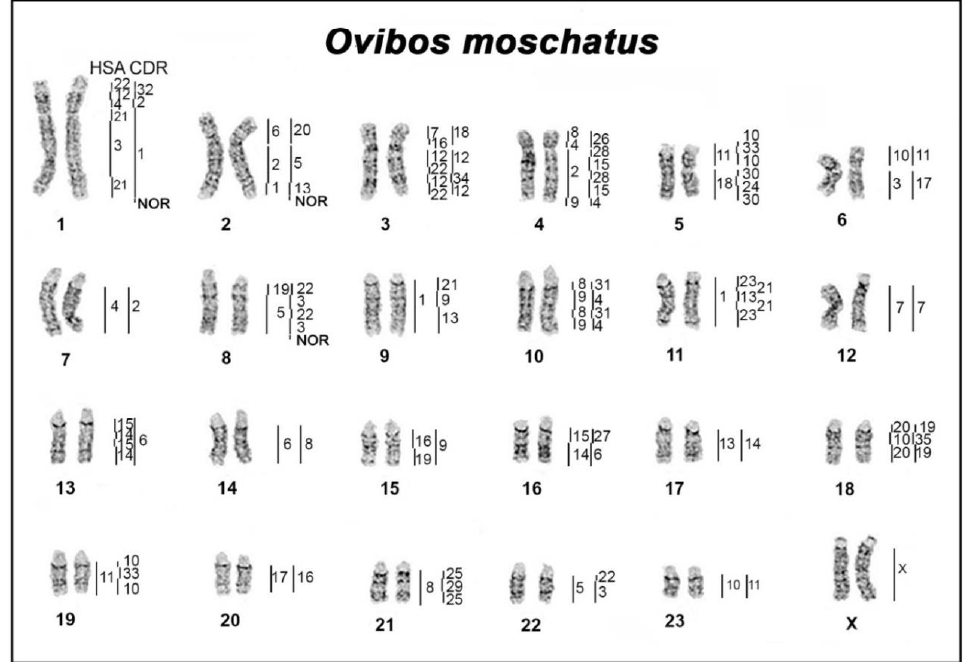
Figure 1. Comparative chromosome painting map of musk ox with homologies to human (HSA) and dromedary (CDR). Nucleolar organizing regions (NOR) show the localization of the nucleolar organizing region.